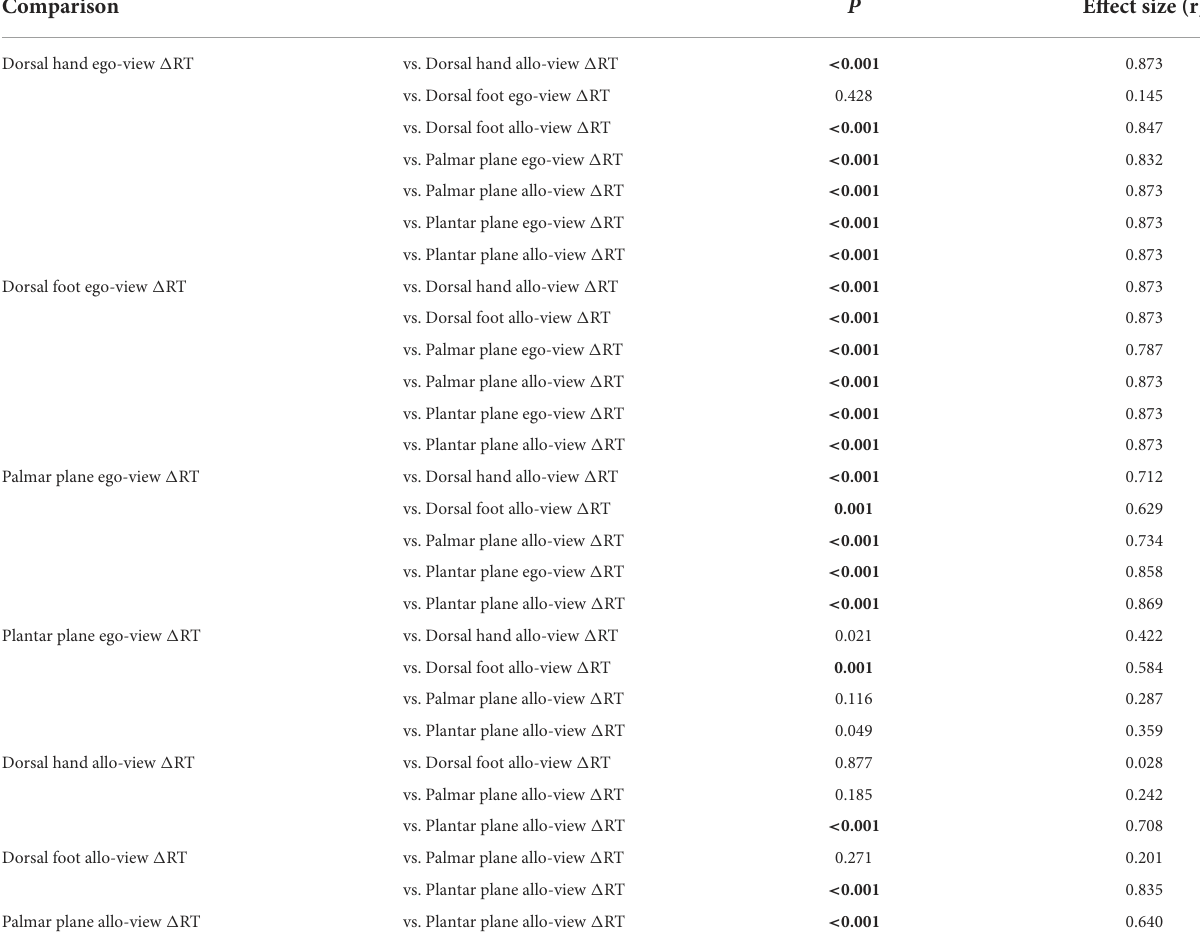
TABLE 1 Results of multiple comparisons between 1 RTs in eight different body part images.